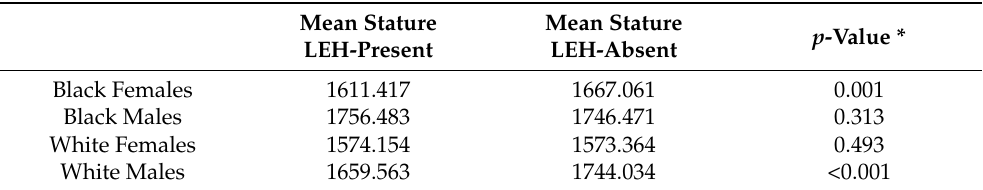
Table 4. Results of independent t -tests comparing statures (mm) for groups with at least one LEH (LEH-Present) and without LEH